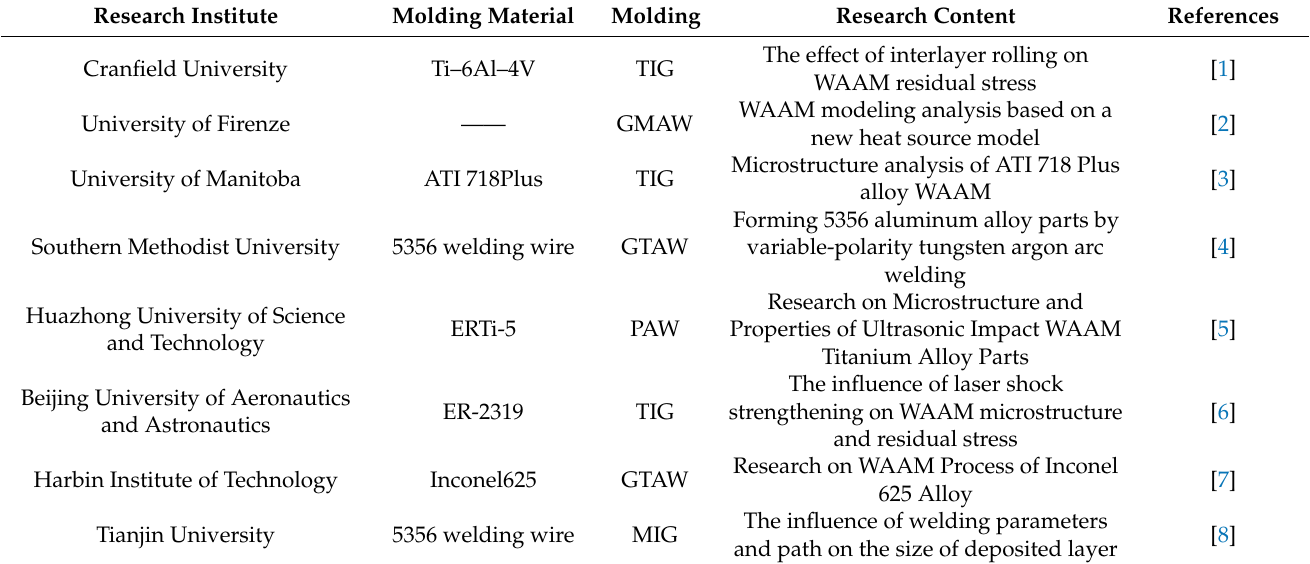
Table 1. Research overview of wire arc additive manufacturing (WAAM) technology in China and